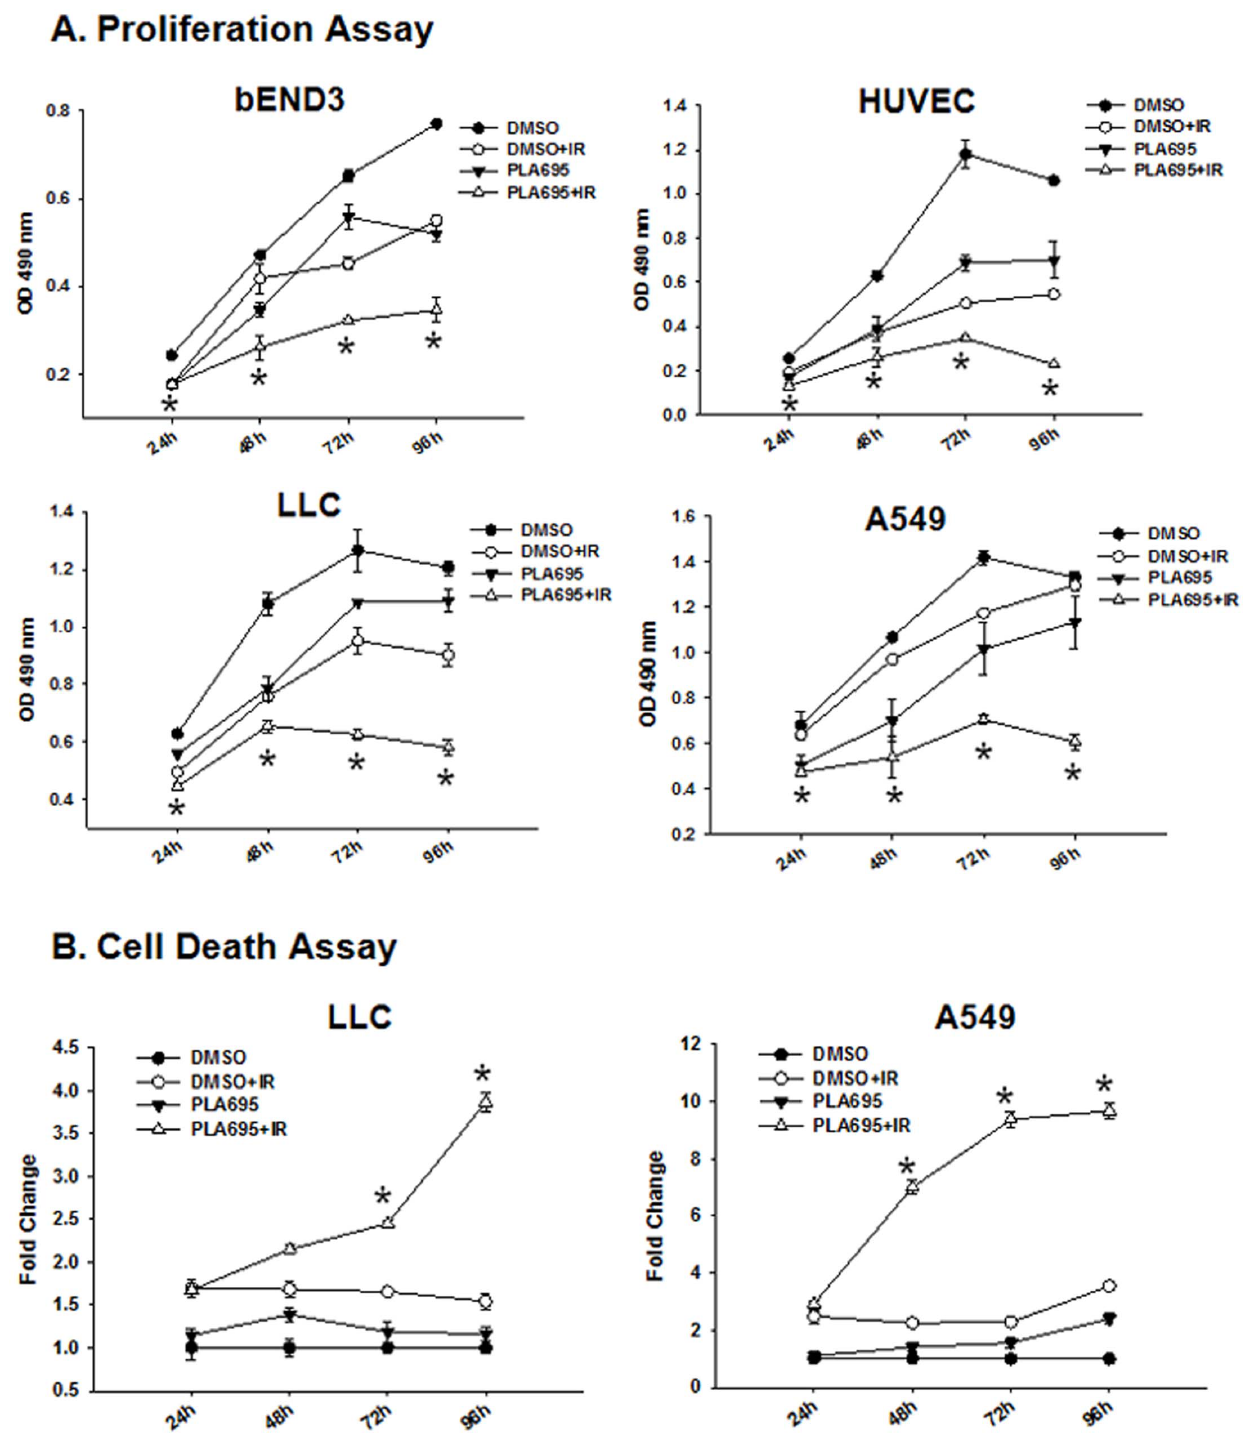
Figure 3. A. PLA-695 reduces proliferation in endothelial and lung cancer cells after irradiation. Equal numbers of bEND3, HUVEC, LLC and A549 cells were plated in 96 well plates and treated with 300 nM PLA-695 for 45 min prior to treatment with 3 Gy. Cell proliferation was determined using a colorimetric cell proliferation assay at 24, 48, 72 and 96 h post treatment. Shown is the absorbance at 490 nm. B. PLA-695 enhances cell death in irradiated lung cancer cells . LLC and A549 cells were treated with 300 nM PLA-695 or DMSO for 45 min prior to treatment with 3 Gy. Cells were stained with Annexin V-APC and propidium iodide and analyzed by flow cytometry at 24, 48, 72 or 96 h after irradiation. Shown are the line graphs indicating fold increase of cell death over control for each treatment with SEM from three experiments.